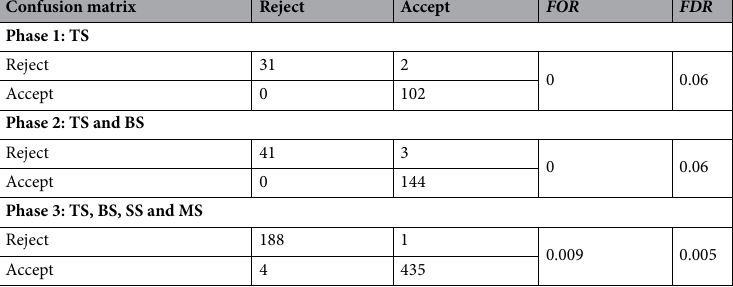
Confusion matrix Reject Accept FOR FDR